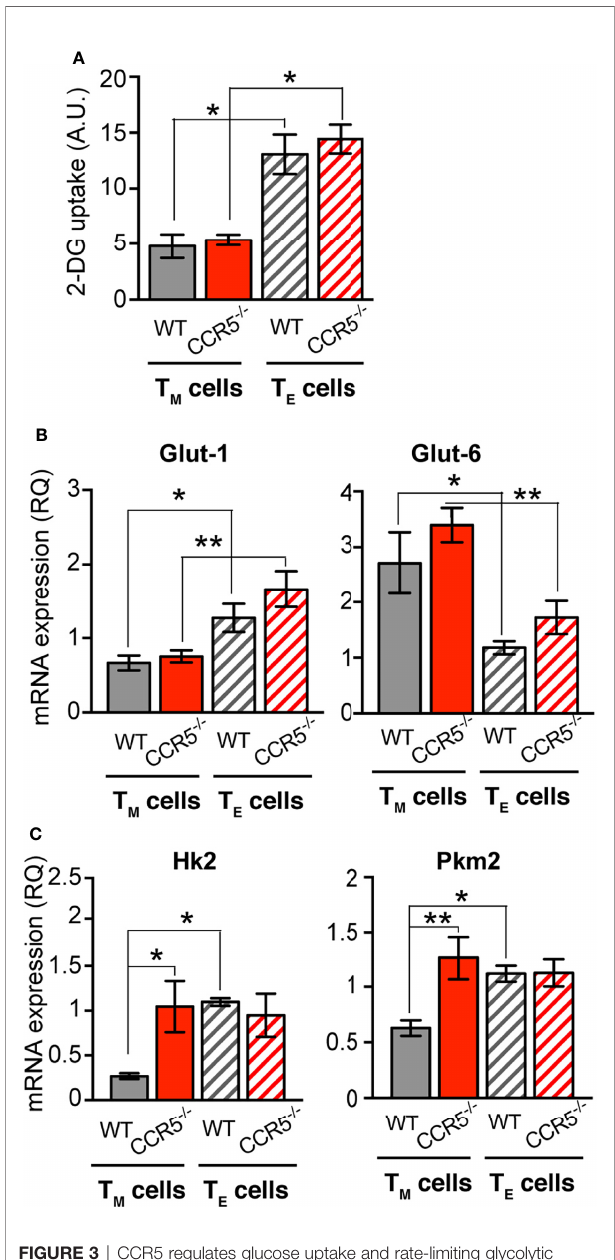
FIGURE 3 | CCR5 regulates glucose uptake and rate-limiting glycolytic enzymes speci fi cally in CD4 + T M cells. (A) Determination of 2-DG uptake in WT and CCR5 -/- T M (solid bars) and T E (hatched bars) cells ( n =3). (B, C) Relative mRNA expression of the glucose transporters Glut-1 and Glut-6 (B) , and the glycolytic enzymes Hk2 and Pkm2 (C) in WT and CCR5 -/- T M and T E lymphoblasts ( n =12). Data are means ± SEM. **p < 0.01, *p < 0.05, two-way ANOVA with Bonferroni post-hoc